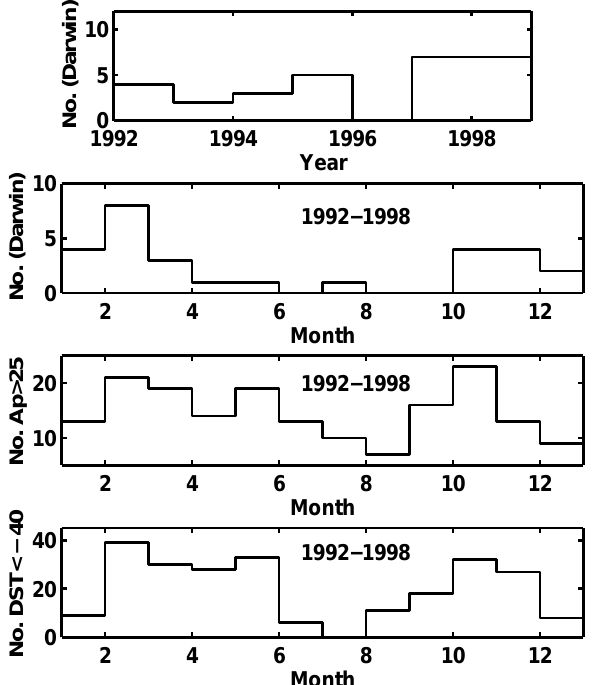
Fig. 2. Ionospheric storm occurrence (Darwin and Townsville) as a function of year and month compared to geomagnetic storm occur- rence ( A p > 25 and D st < − 40) over the period 1992–1998.